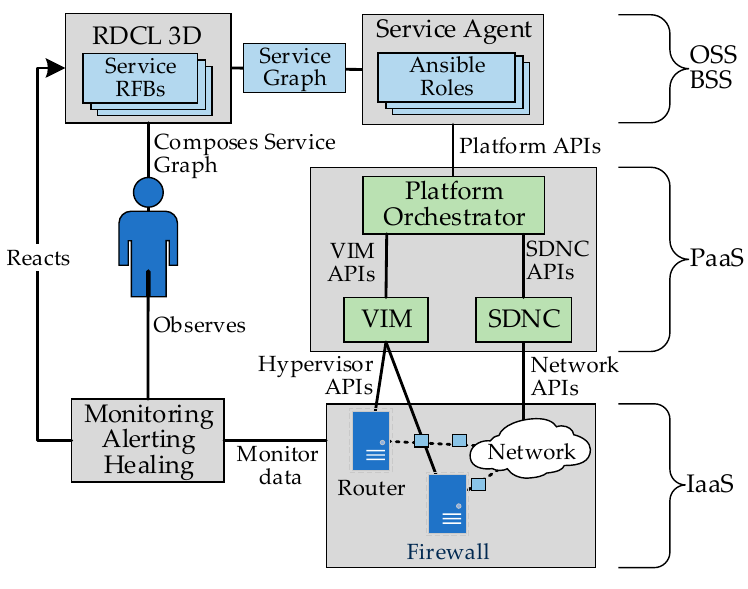
Figure 7. VNFaaS Proof of Concept.